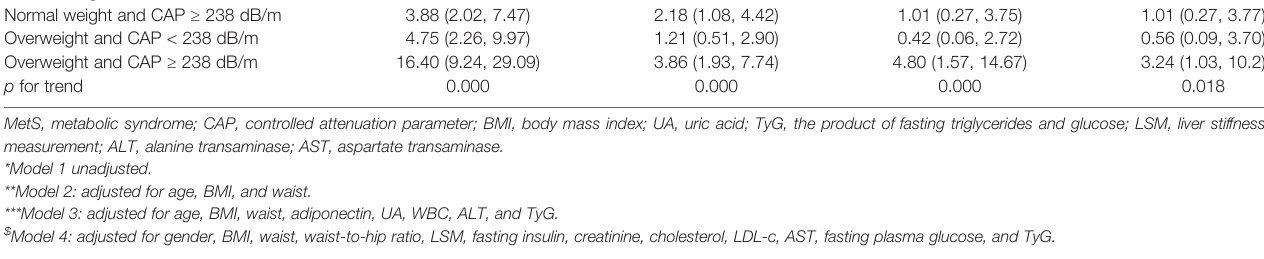
TABLE 6 | Comparison of clinical characteristics in subjects with no MetS components based on whether they were with or without hepatic steatosis. Characteristics